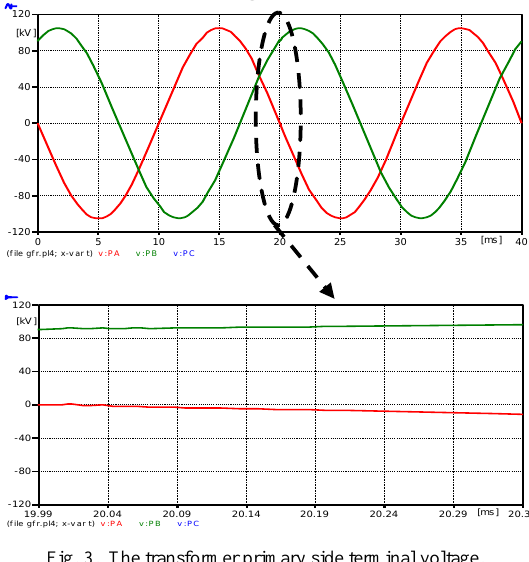
Fig. 3. The transformer primary side terminal voltage.